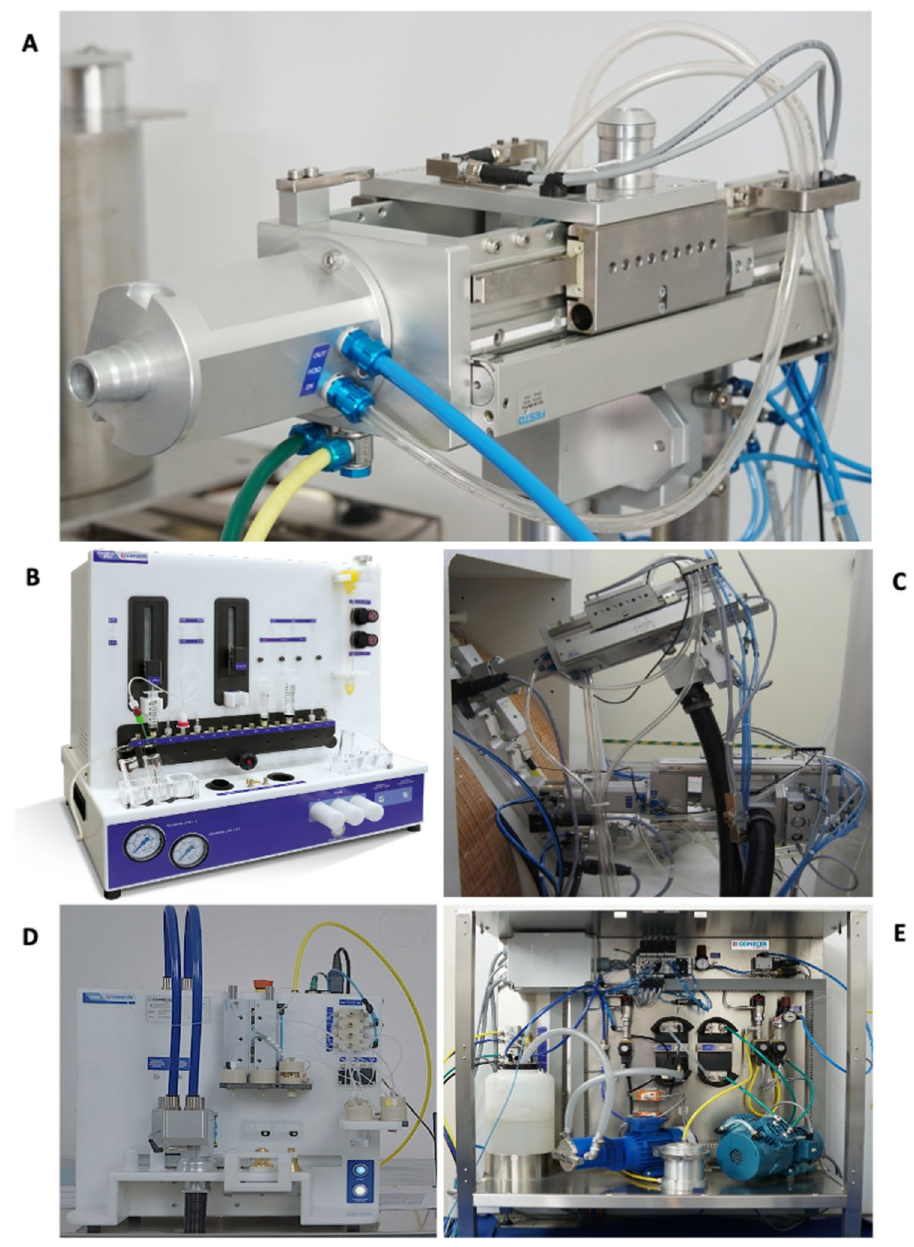
Figure 1. Panel ( A ), irradiation unit (PTS). Panel ( B ), TADDEO-PRF. Panel ( C ), coupling with two different PTS and a reference cyclotron. Panel ( D ), EDS. Panel ( E ), cooling